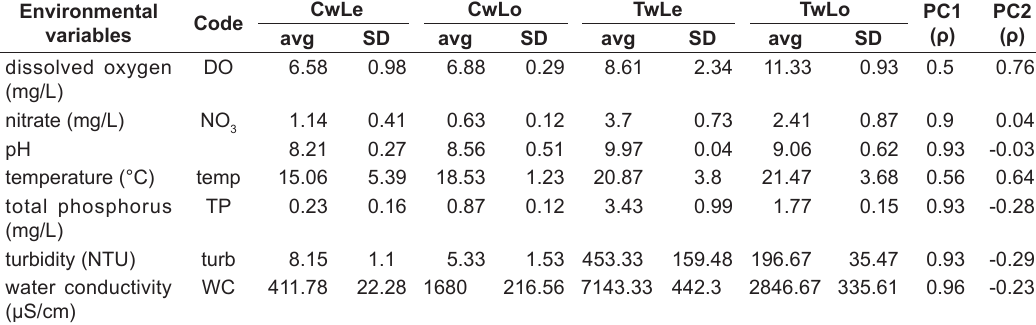
Table 1. Environmental variables measured in different sampling sites of the Sauce Grande River. Environmental variables